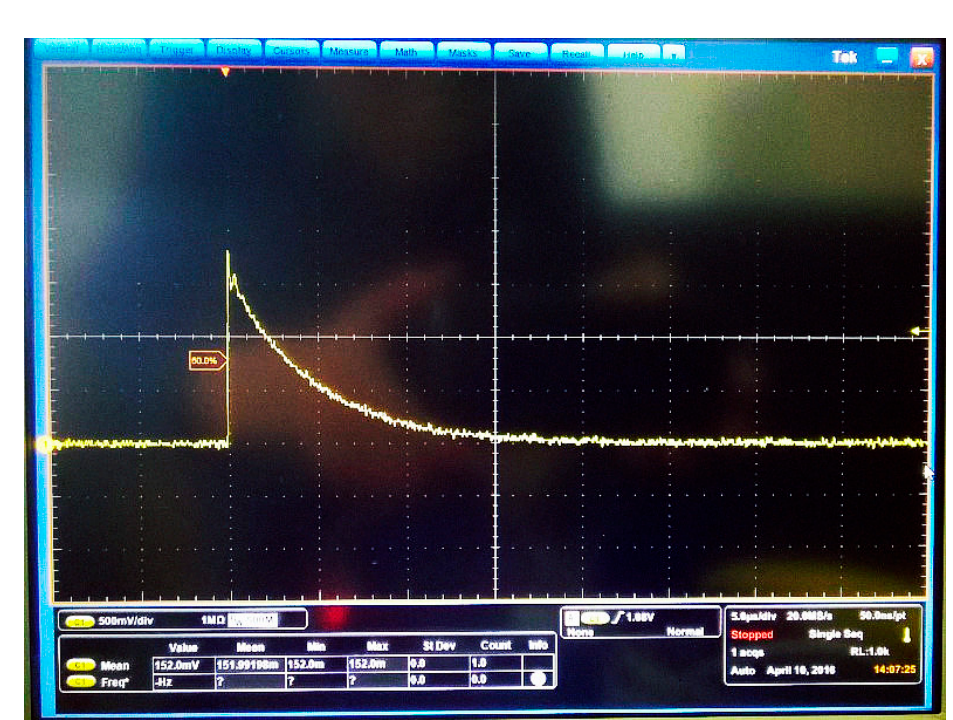
Figure 10. The detection waveform of a PD signal generated by PD emitter.